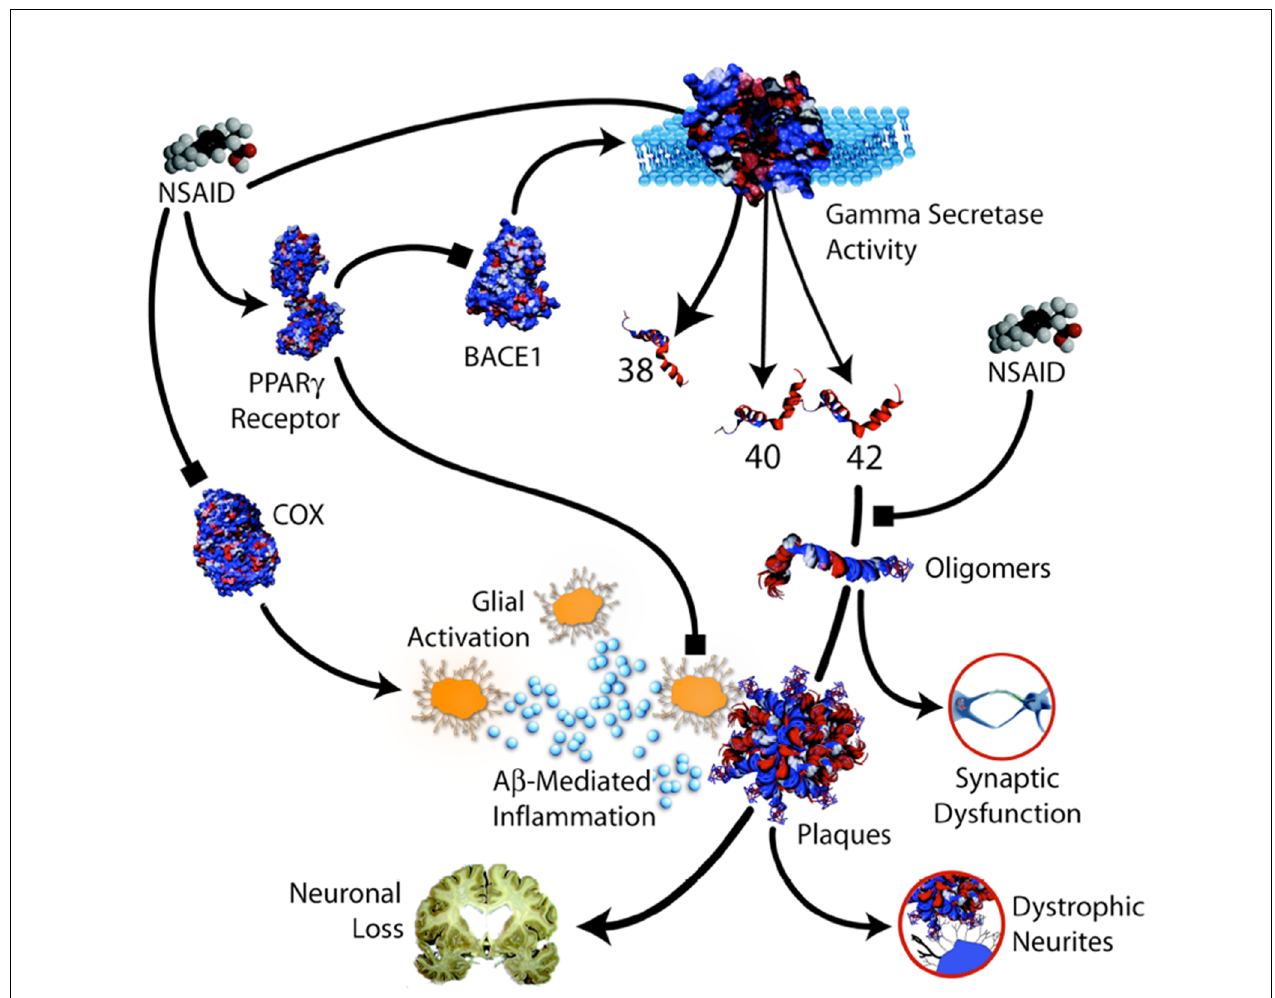
FIGURE 2 | Potential protective mechanisms of NSAIDs in AD (from Weggen et al., 2007